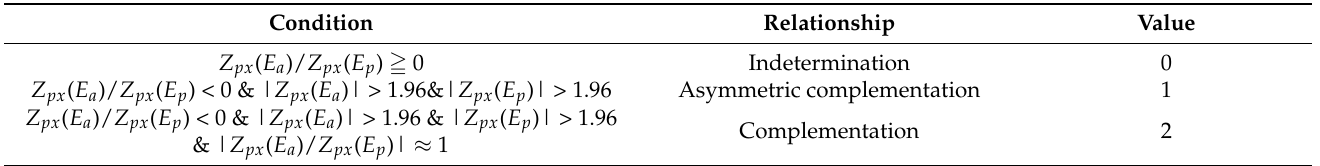
Table 4. Complementarity relationship between AET and